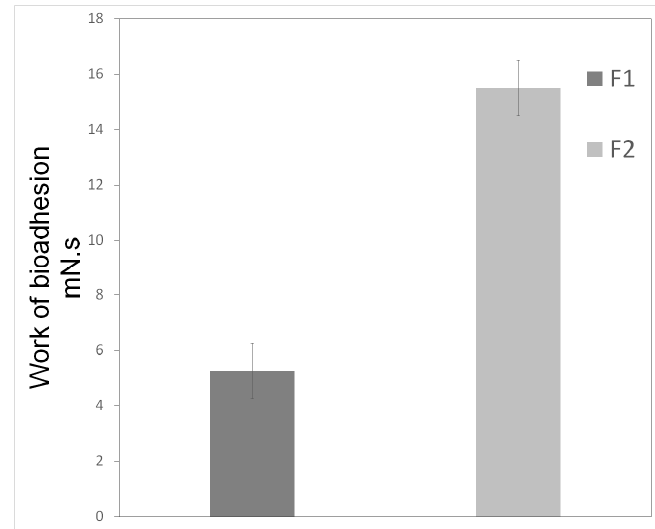
Figure 7. Parameters of in vitro bioadhesion test of systems composed of poloxamer 407 dispersion (1%), oleic acid, and PPG-5-CETETH-20. Data were collected at 37 ± 1°C and values represent mean ± standard deviation (SD) of seven replicates.